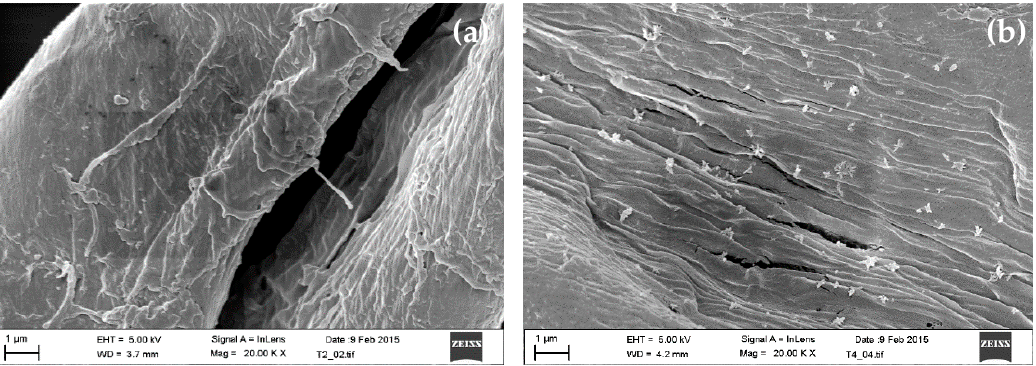
Figure 2. FESEM micrographs of cotton fabrics: ( a ) non-functionalized and ( b ) In Situ functionalized with CuO NPs.